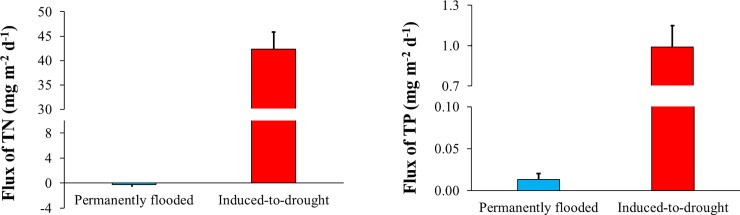
Average ± standard error of total nitrogen (TN) and total phosphorus (TP) release rates (mg m-2
d-1) from permanently flooded (blue) and induced-to-drought cores (red)during the rewetting period. For a better view of results, only the upper standard error is shown.